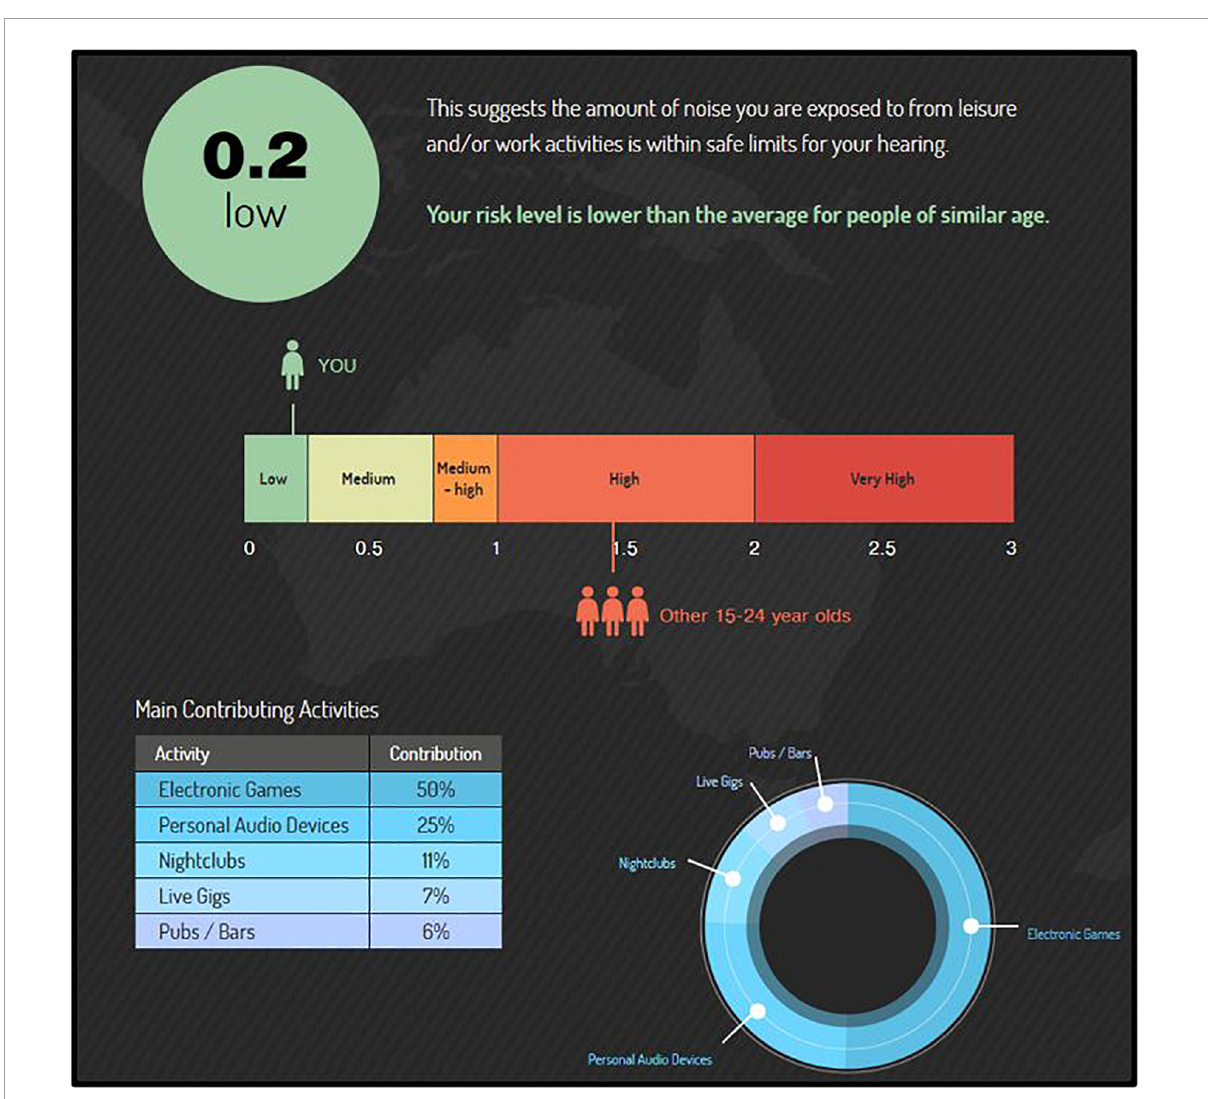
FIGURE1 The “Noise Risk Calculator” (https://knowyournoise.nal.gov.au/noise-risk-calculator) is a free, online tool provided within the National Acoustics Laboratories (NAL) “Know Your Noise” campaign. The results shown here are from a participant with a score (score = 0.2) indicating lower risk than the daily NIOSH acceptable noise limit (score = 1.0), and lower risk on average than peers in their age group (average score = 1.4). The percentile breakdown of the participant’s most hazardous, typical activities is included in the bottom left